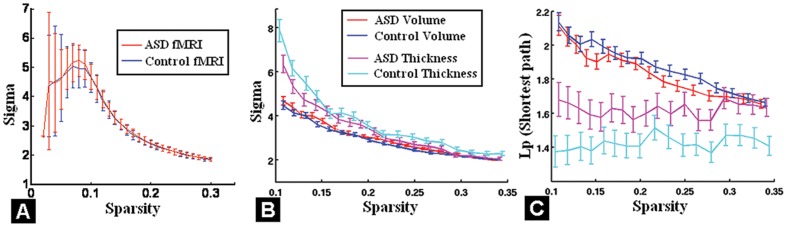
A: Small-world network analysis based on fMRI data showed similar efficiency (including both local and global) between children with ASD and TD controls. Small-worldness analysis based on regional volume (red and blue colors) showed no significant differences of total efficiency (B) and global efficiency (C) between children with ASD and controls neither. However, small-worldness analysis based on structural cortical thickness measure showed reduced total efficiency (B), specifically decreased global efficiency (i.e. shortest path length) (C) in ASD group (magenta color) compared to TD group (cyan color). Error bar denotes standard deviation at each sparsity level after scaling to a random network with the same number of degree.